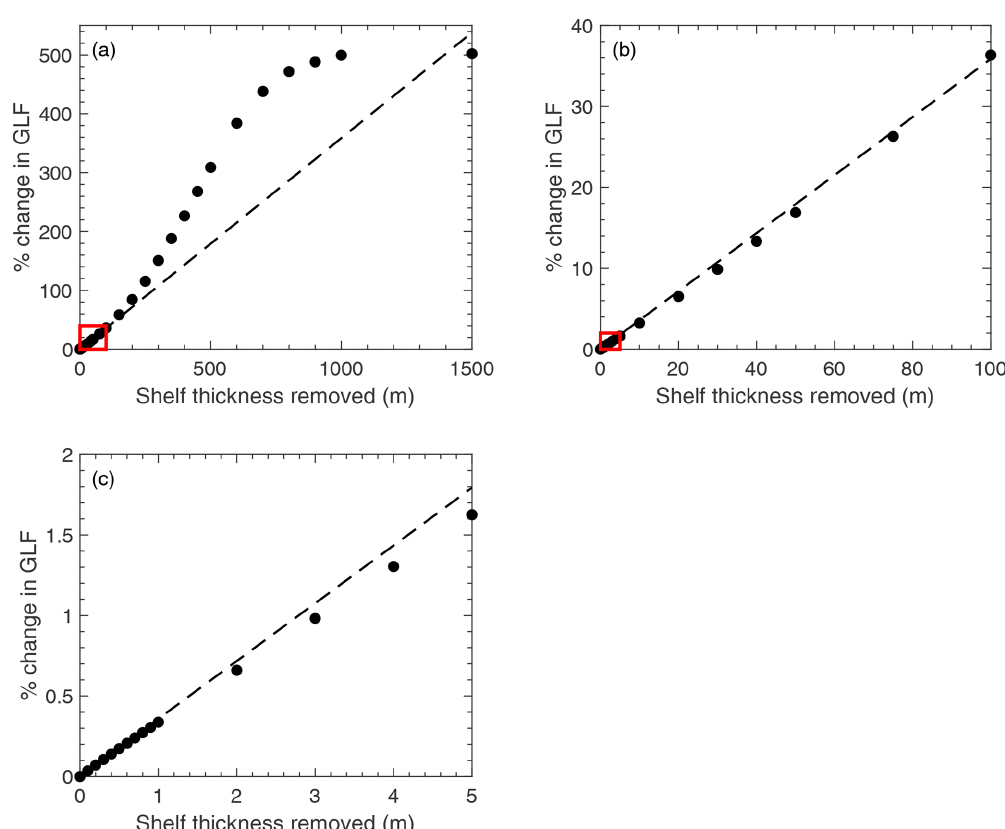
Figure B1. The percentage change in grounding line flux is plotted as a function of the “uniform” thickness perturbation applied (a) . The dashed line is the straight line that passes through the origin and the 0.1m “uniform” thinning point. Panel (b) is the region shown in the red box in panel (a) , and (c) is the region in the red box in (b)